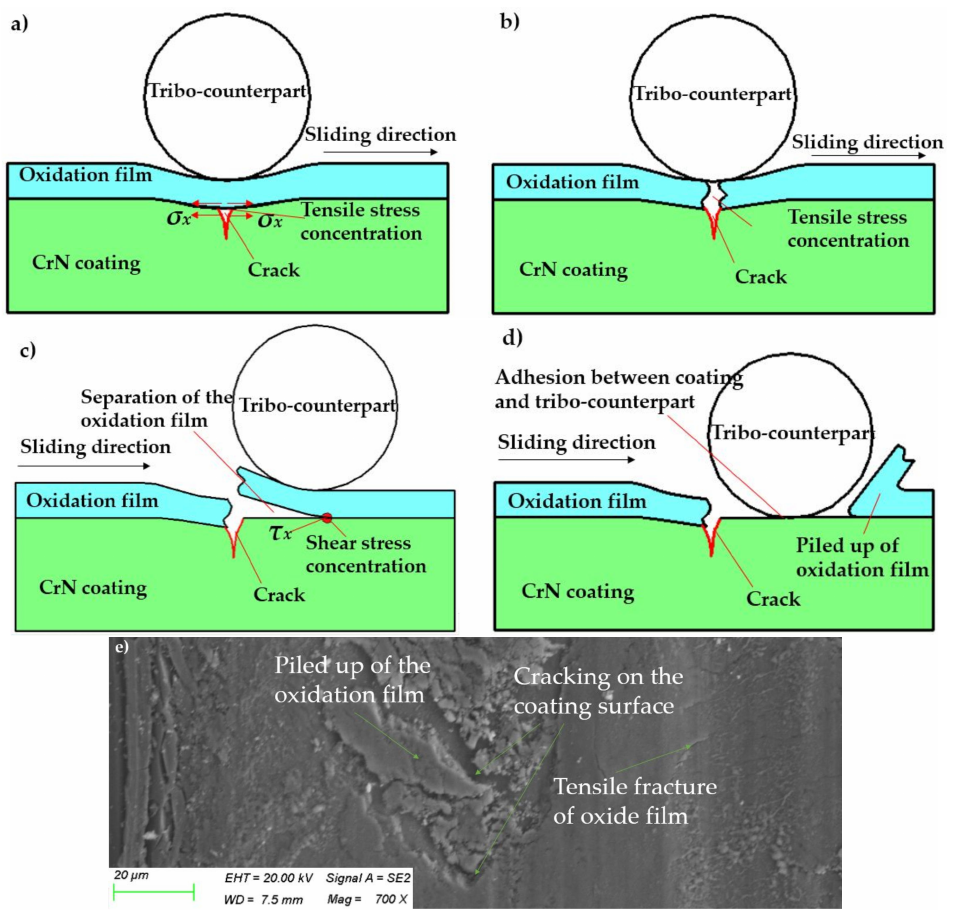
Figure 13. The schematic drawing of the failure of oxidation film: ( a ) tensile stress concentration; ( b ) tensile fracture of oxidation film; ( c ) shear stress concentration; ( d ) adhesion occurred after the failure of oxidation film; and ( e ) verification of the failure mechanisms from the wear scar morphologies of the 2 µ m CrN coated M50 disks under the load of 15 N and temperature of 500 ◦ C.